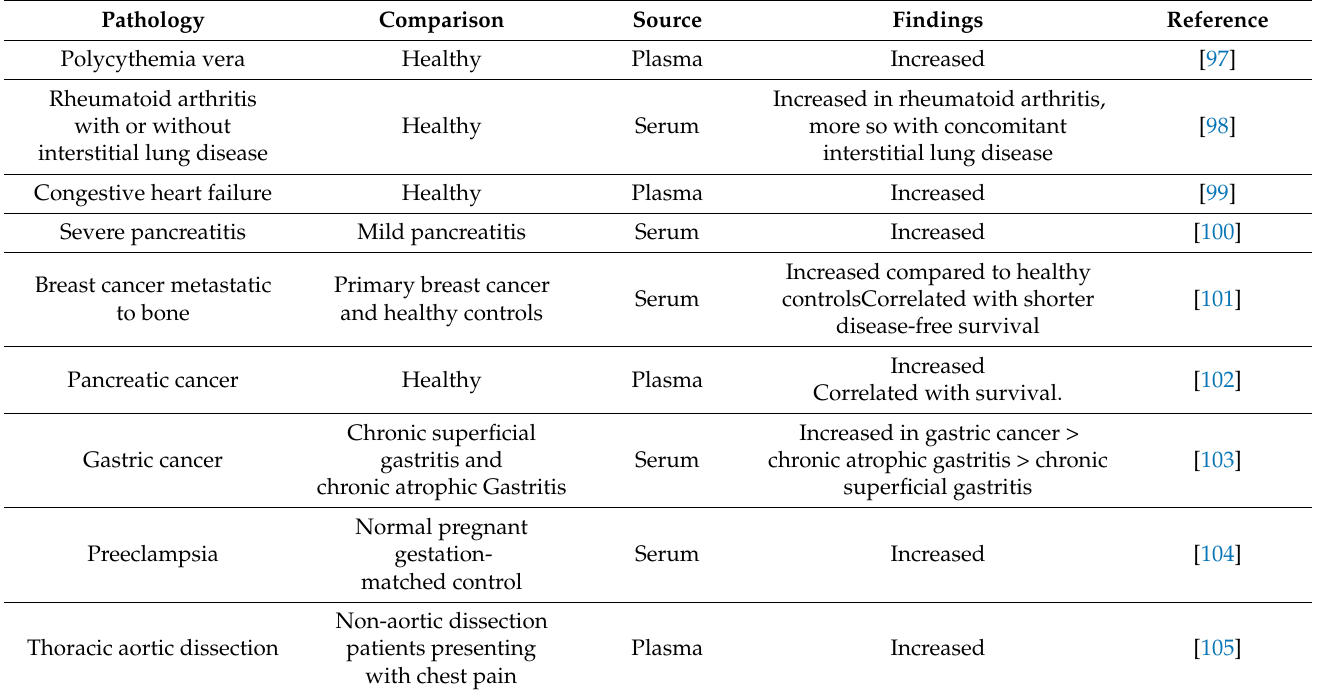
Table 3. Pathologies where IL11 from peripheral blood has been reported to be increased in hu- man